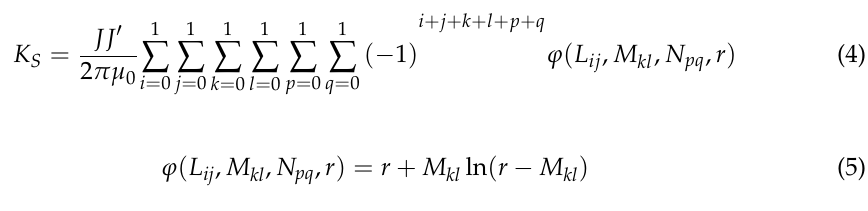
Figure 3. Principle of magnetic quasi-zero stiffness. ( a ) ateady state, ( b ) applying external load. According to the model of magnetic charge [20,22], the stiffness of the magnetic spring can be obtained by Equation (4).